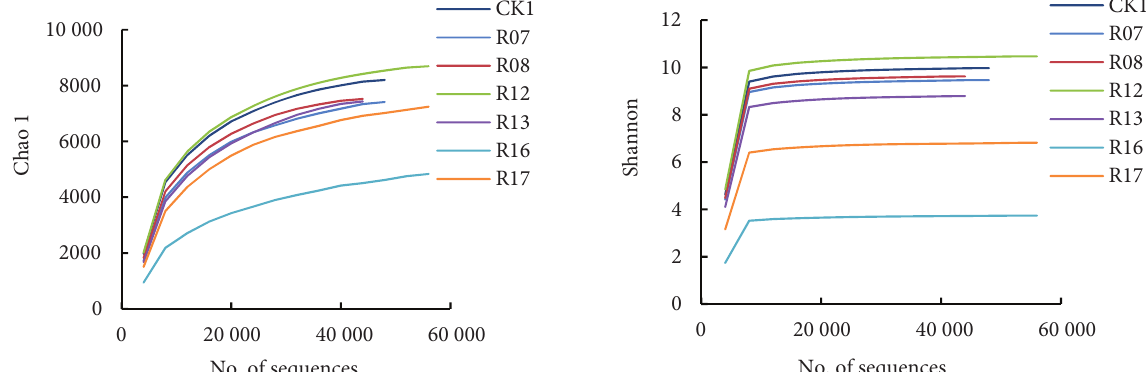
Figure 2. Rarefaction curves of the Chao 1 and Shannon indices at 97% sequence identity for